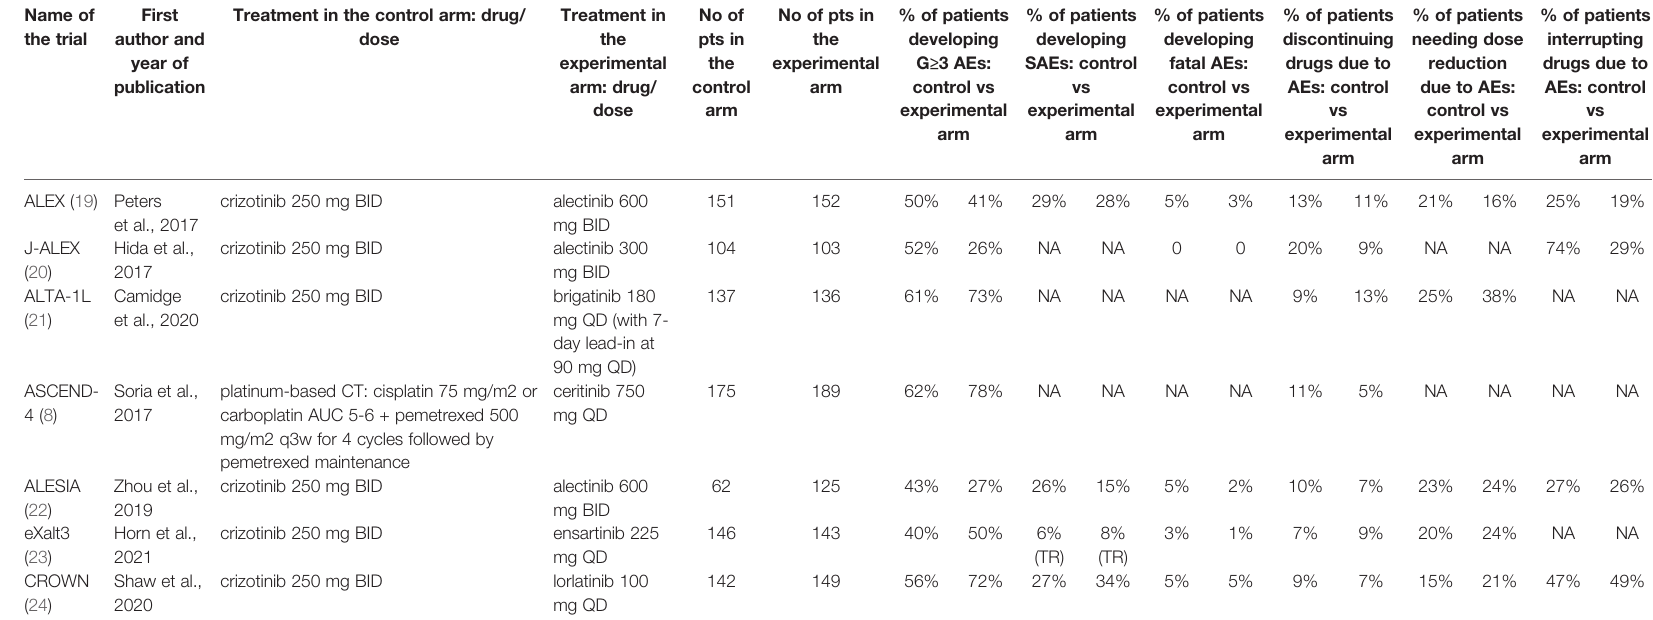
TABLE 2 | Safety data from the selected randomized clinical trials in patients with ALK-translocated lung